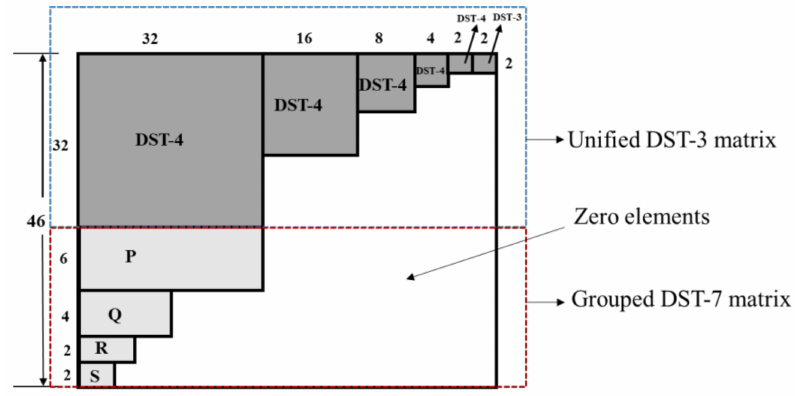
Figure 1. Common sparse unified